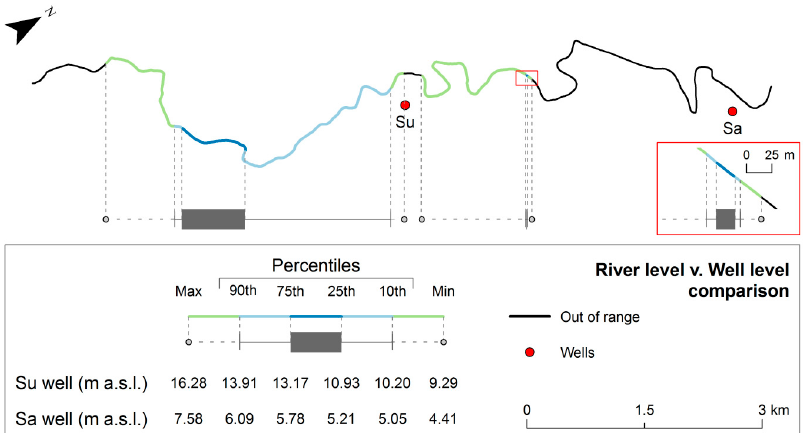
Figure 16. Comparison of borehole hydraulic head changes and the distribution of river level elevations. The borehole piezometric heads, which vary most frequently between the 25th and 75th percentile, correspond to the river bed elevations along the blue sections of the river profile.